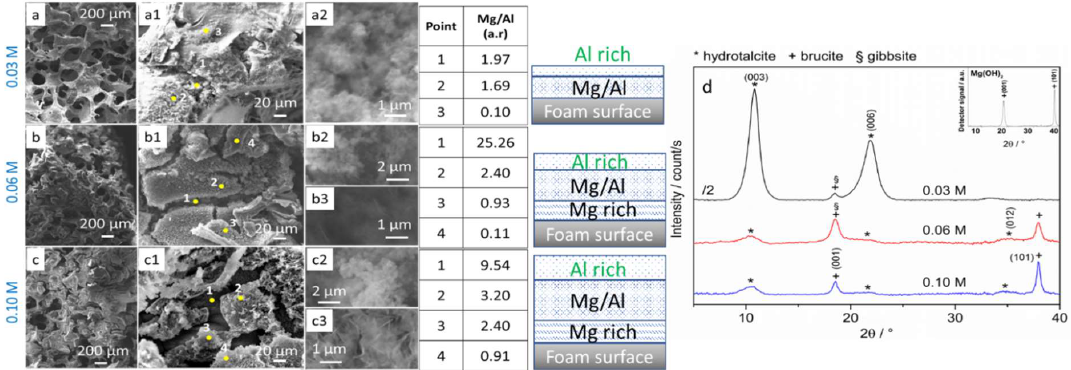
Figure 4. Effect of total metal nitrate concentration on the properties of the Mg/Al HT coatings on FeCrAlloy at −1.2 V vs. SCE for 2000 s. SEM images of coated foams: 0.03 M ( a , a1 , a2 ), 0.06 M ( b , b1 – b3 ), and 0.10 M ( c , c1 – c3 ), and ( d ) XRD patterns of coated plates. The table summarizes Mg/Al ratios obtained from EDS spectra in the regions of interest indicated by the numbers. Adapted from [55].